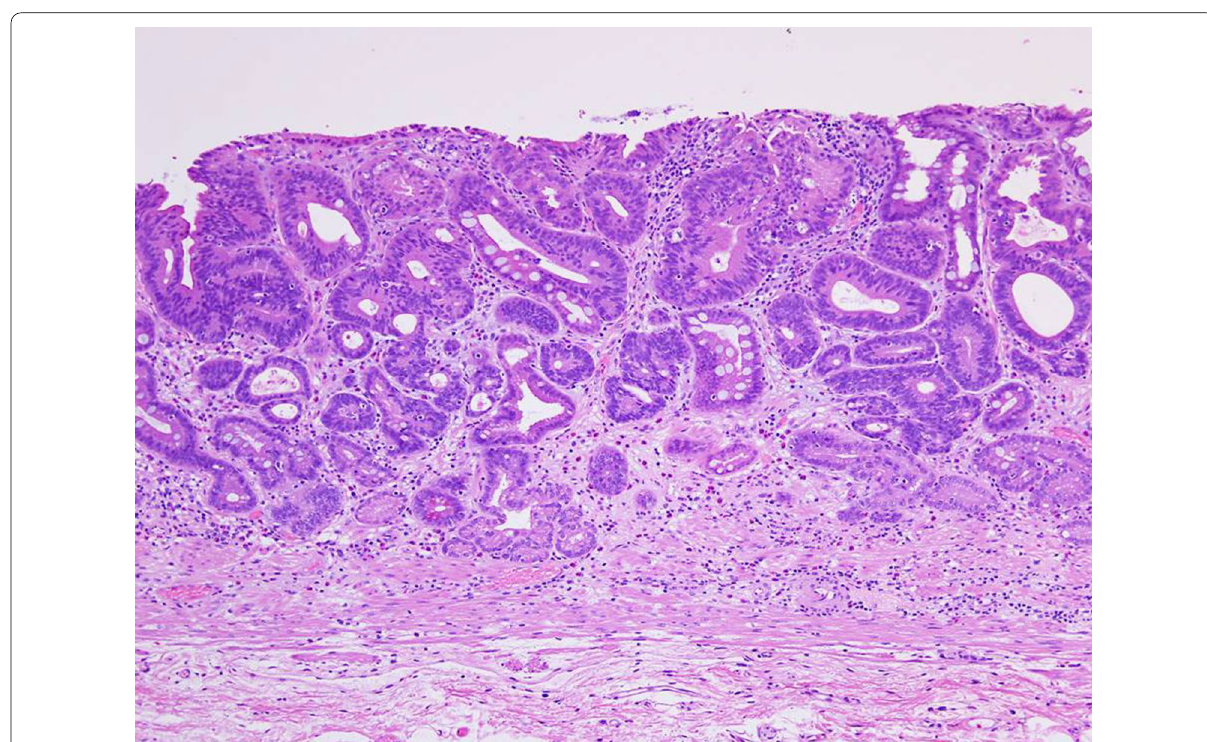
Fig. 5 Histopathological findings of the 0–IIc tumor in the lesser curvature of the gastric angle showed well-differentiated adenocarcinoma confined to the mucosa (hematoxylin and eosin